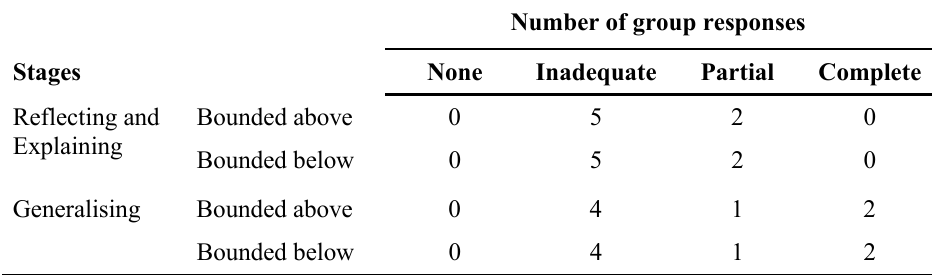
Table 2 : Results on group constructions for bounded below/above (N = 7) Number of group responses None Inadequate